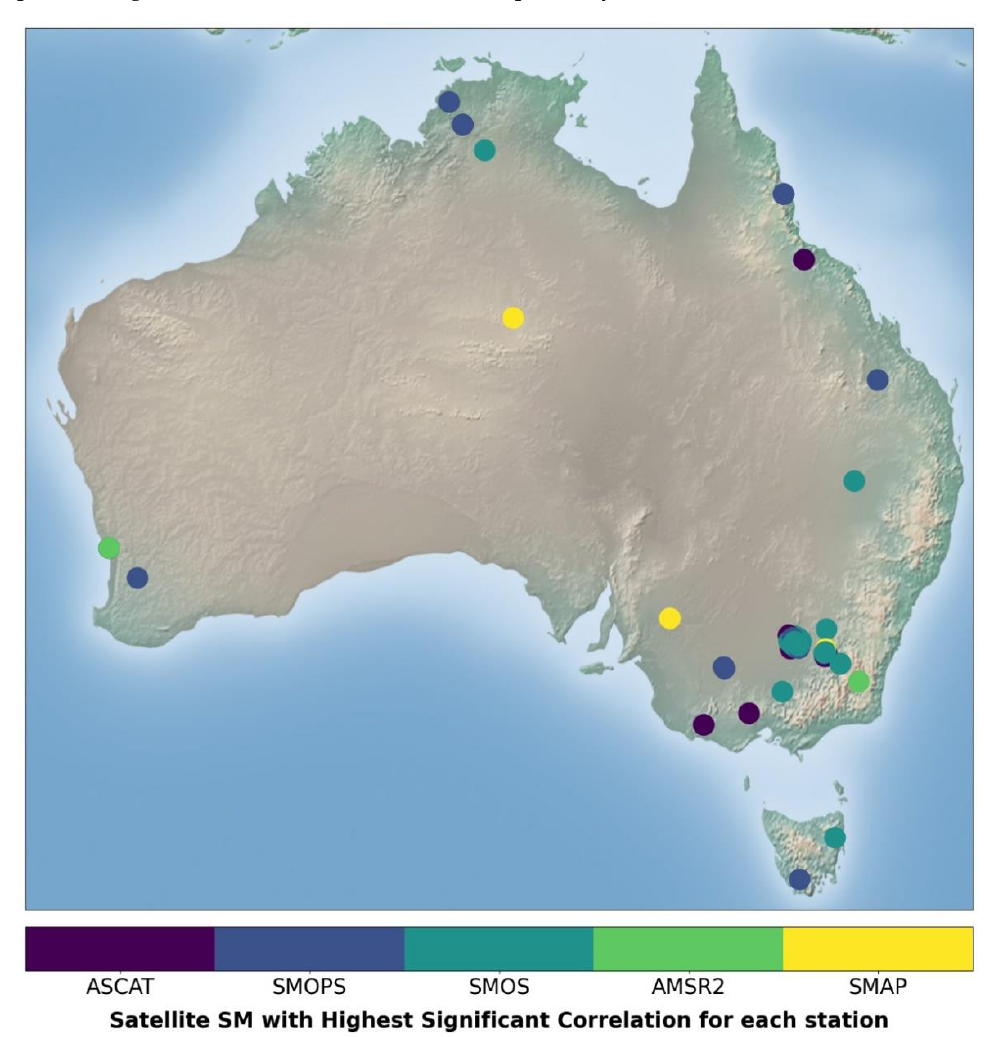
Figure 5. Satellite SM product with the highest significant correlation for each station.